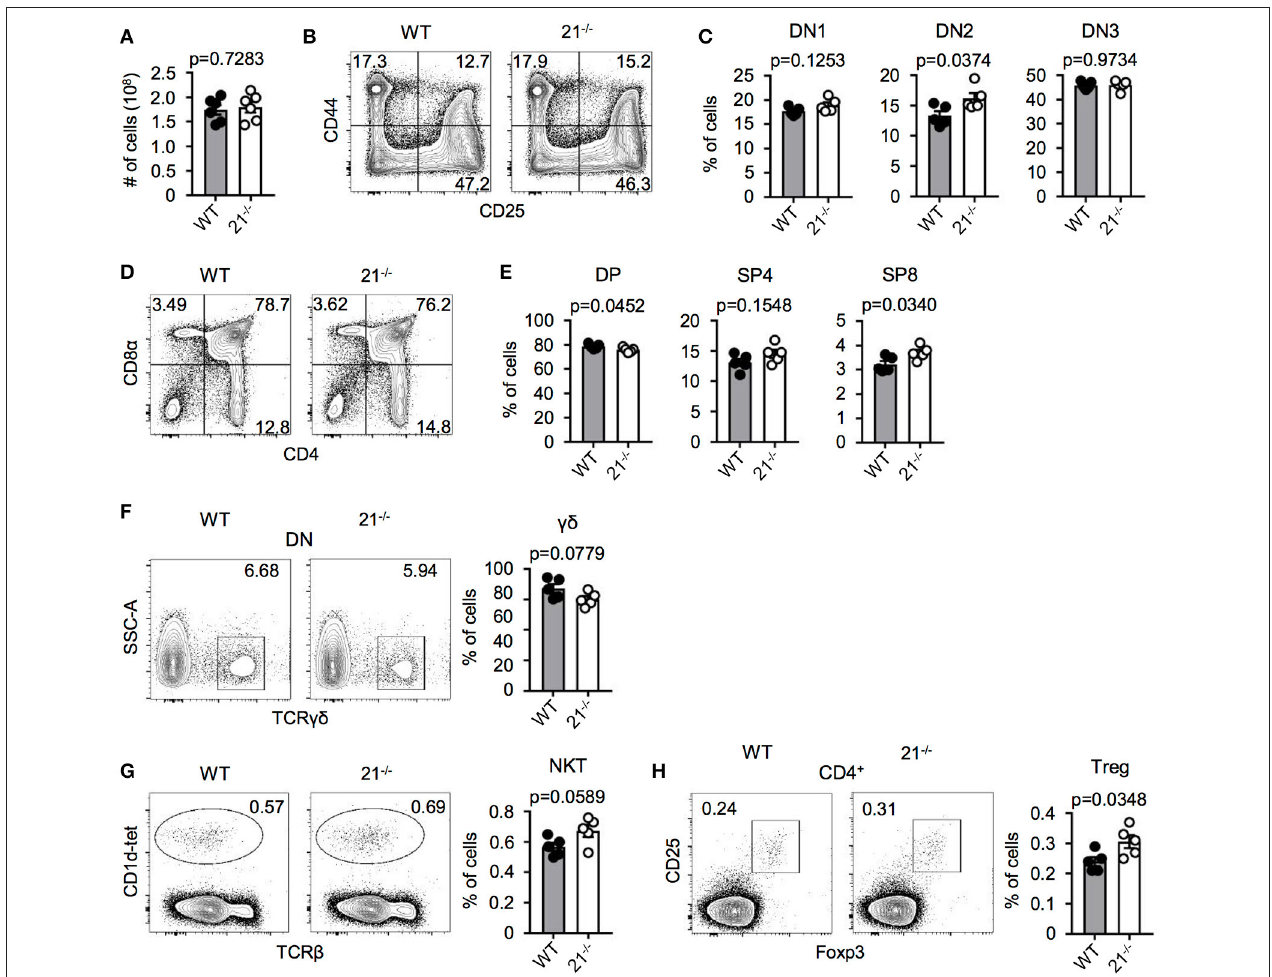
FIGURE 2 | miR-21 is largely dispensable for steady-state T-cell development in the thymus. (A) Total cellularity of thymi from WT and miR-21 − / − mice, n = 6 for each genotype. (B) Representative flow cytometric analysis of lineage-depleted thymi from WT and miR-21 − / − mice stained with antibodies against CD25 and CD44. Numbers in quadrants represent frequencies. (C) Statistical analysis of flow cytometric results shown in (B) , n = 5. (D) Representative flow cytometric analysis of thymi from WT and miR-21 − / − mice stained with antibodies against CD4 and CD8 α . Numbers in quadrants represent frequencies. (E) Statistical analysis of flow cytometric results shown in (D) , n = 5. (F) Representative flow cytometric and statistical analysis of thymi from WT and miR-21 − / − mice stained with antibodies against CD4, CD8 α and TCR γδ . Numbers in right corners of plots represent frequency, n = 5. (G) Representative flow cytometric and statistical analysis of thymi from WT and miR-21 − / − mice stained with CD1d-tet and antibody against TCR β . Numbers in right corners of plots represent frequency, n = 5. (H) Representative flow cytometric and statistical analysis of thymi from WT and miR-21 − / − mice stained with antibodies against CD4, CD25 and Foxp3. Numbers in left corners of plots represent frequency, n =